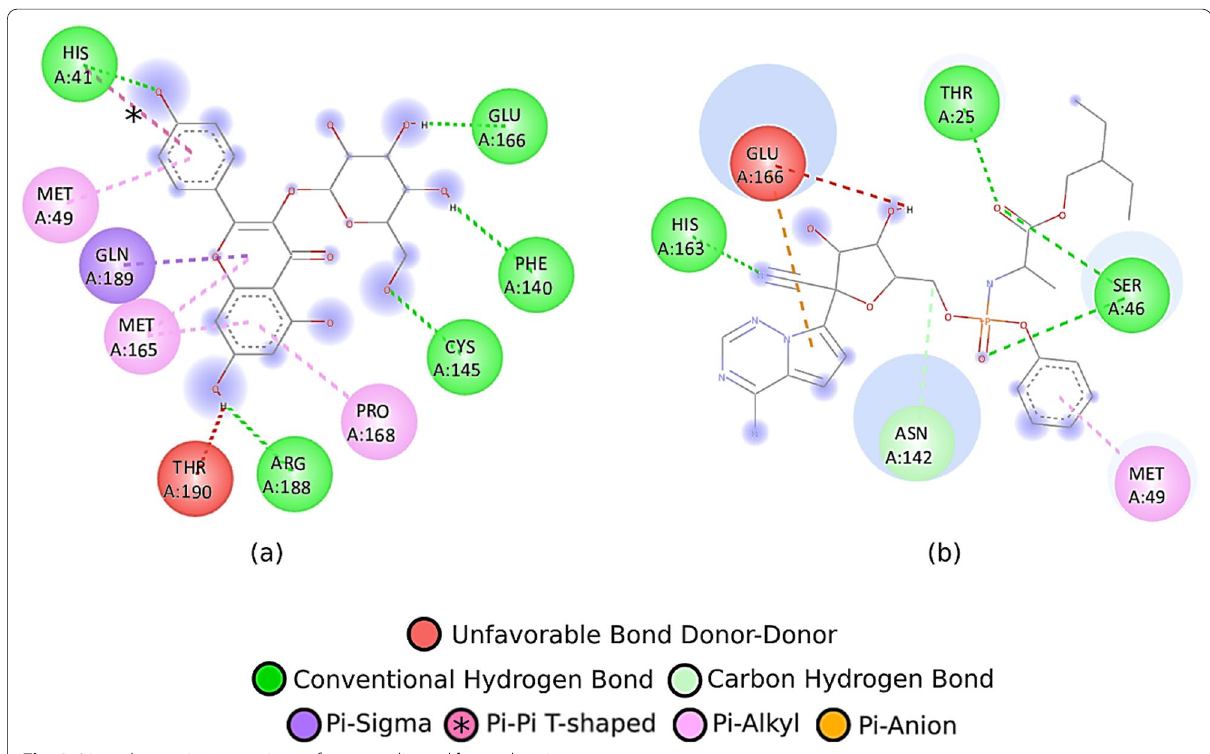
Fig. 3 Ligand–protein interactions of a astragalin and b